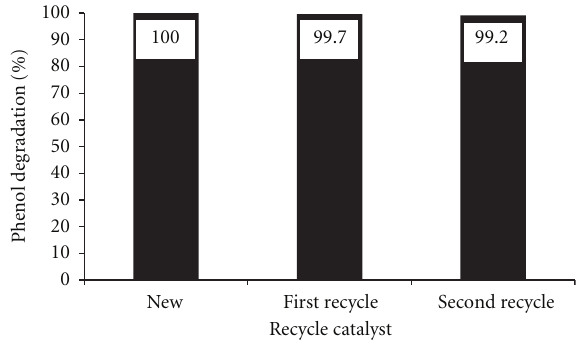
Figure 12: E ff ect of catalyst recycling on the photocatalytic degradation of phenol under 120 min of irradiation duration (air flow rate = 0.3 L/min, initial phenol concentration = 30mg/L, and pH =